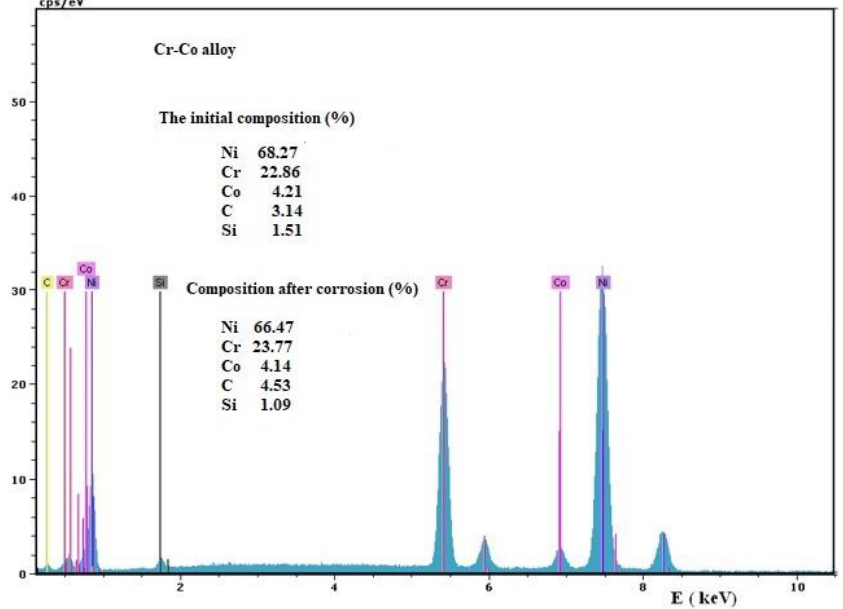
Figure 9. EDX spectrum of the Cr-Co sample before corrosion and surface compositions, initially and after corrosion.